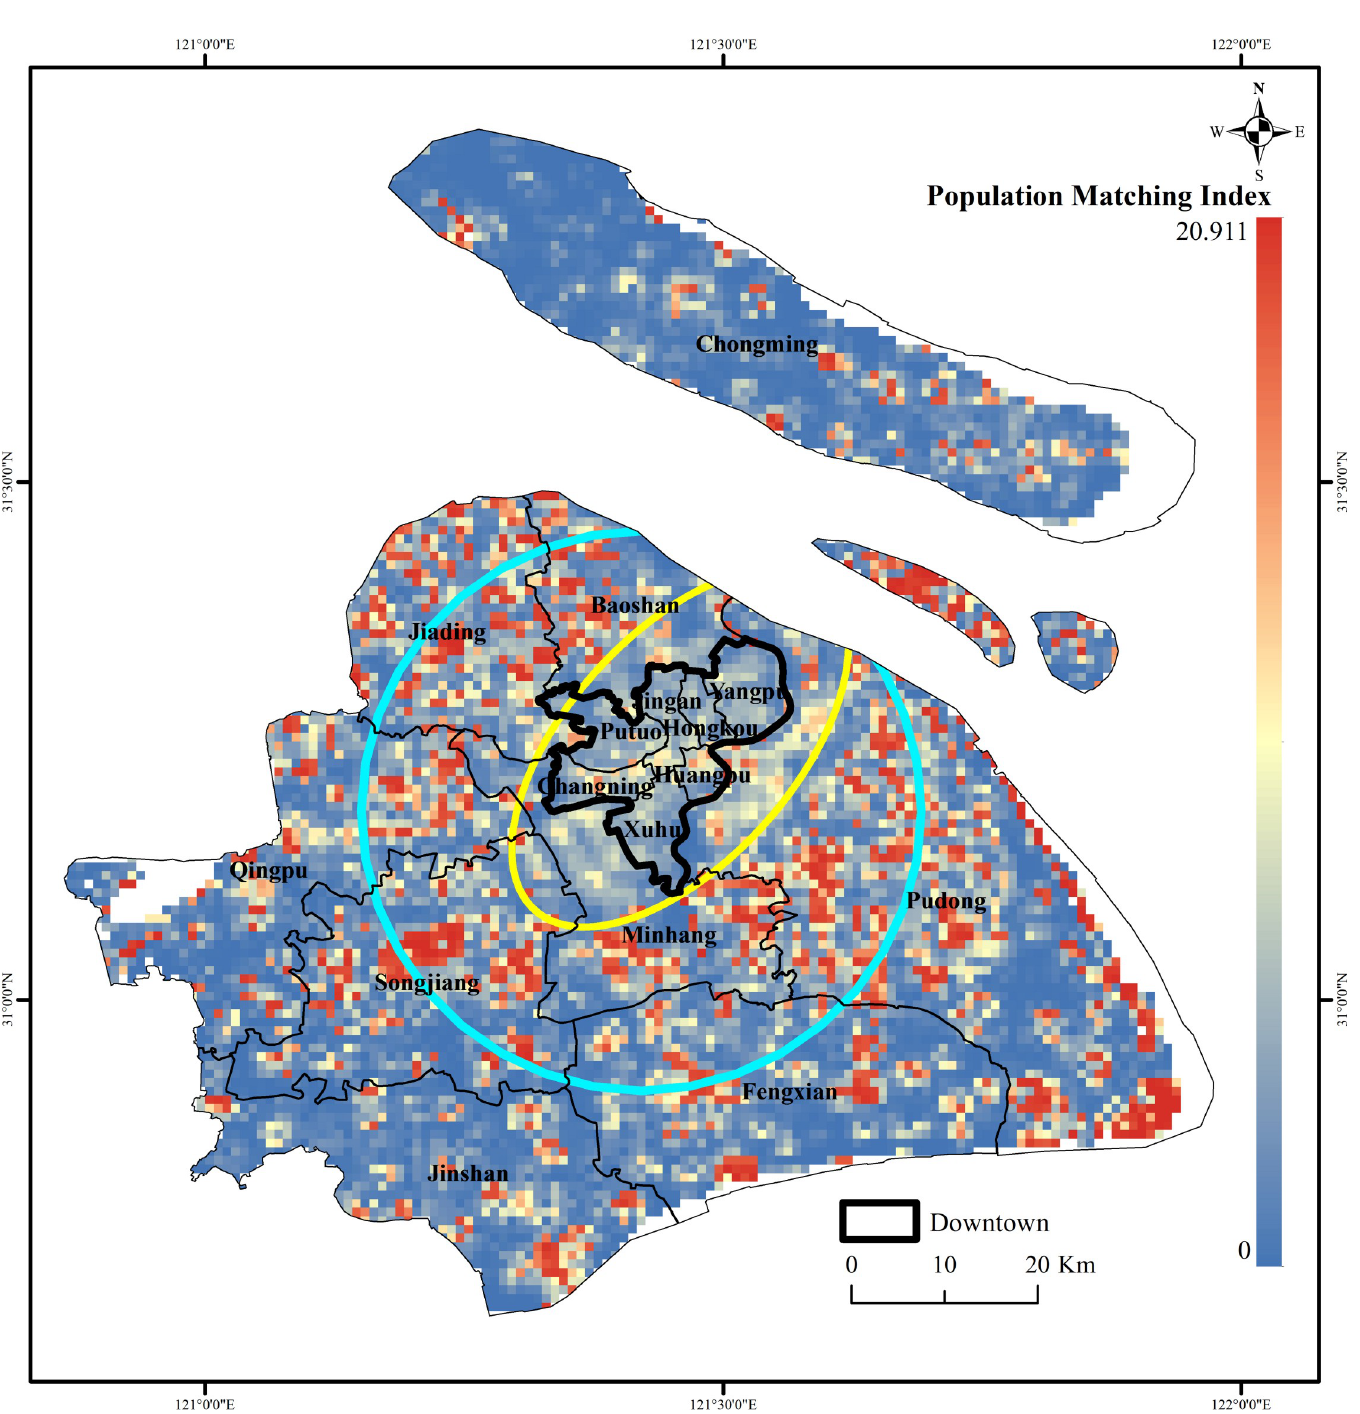
Fig 6. Distribution of facility population supporting index in the 15min-CLC in Shanghai. (Image Source: https://www.naturalearthdata.com/downloads/10m- cultural-vectors/).